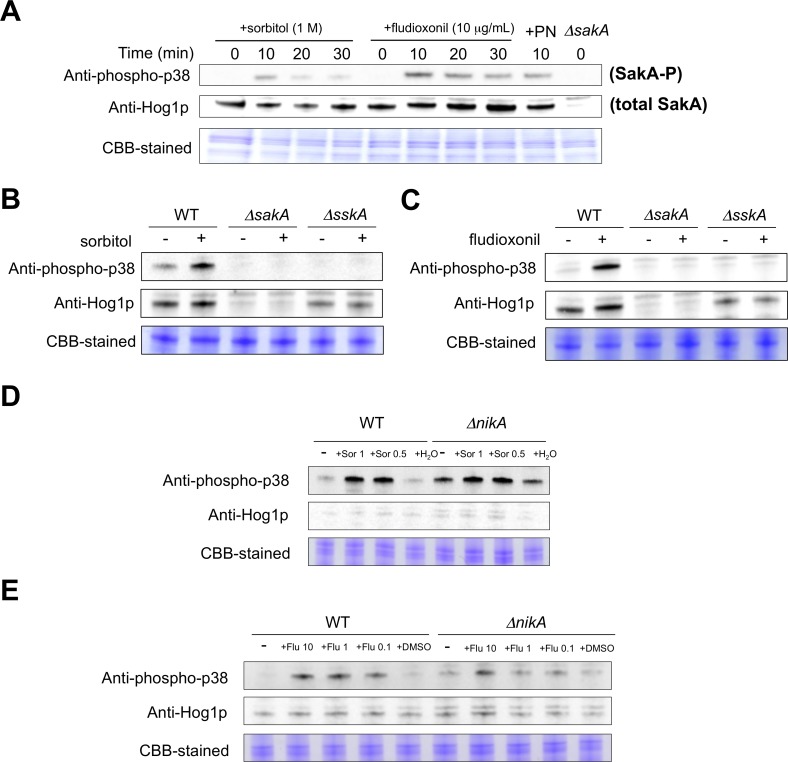
Immunoblot analysis for phosphorylation of the SakA MAPK in response to osmotic or fungicide stress.(A) The WT strain was grown for 18 h at 37°C. Then, sorbitol (1 M final concentration), fludioxonil (10 µg/mL final concentration), or pyrrolnitrin (1 µg/mL) was added. The mycelium was harvested at the indicated times, and total proteins were extracted. Anti-phospho-p38 was used to detect the phosphorylation of SakA, and anti-Hog1p was used to detect the total protein of SakA. A Coomassie Brilliant Blue (CBB)-stained gel is shown as a loading control. (B and C) WT, ΔsakA, and ΔsskA were grown with or without sorbitol (1 M final concentration) (B) or fludioxonil (10 µg/mL final concentration) (C). CBB-stained gels are shown as loading controls. (D and E) WT and ΔnikA were grown with or without sorbitol (0.5 and 1 M final concentrations) (D) or fludioxonil (0.1, 1, and 10 µg/mL final concentrations) (E). CBB-stained gels are shown as loading controls. The same volume of water (D) or DMSO (E) was added to the culture instead of sorbitol or fludioxonil as a control.